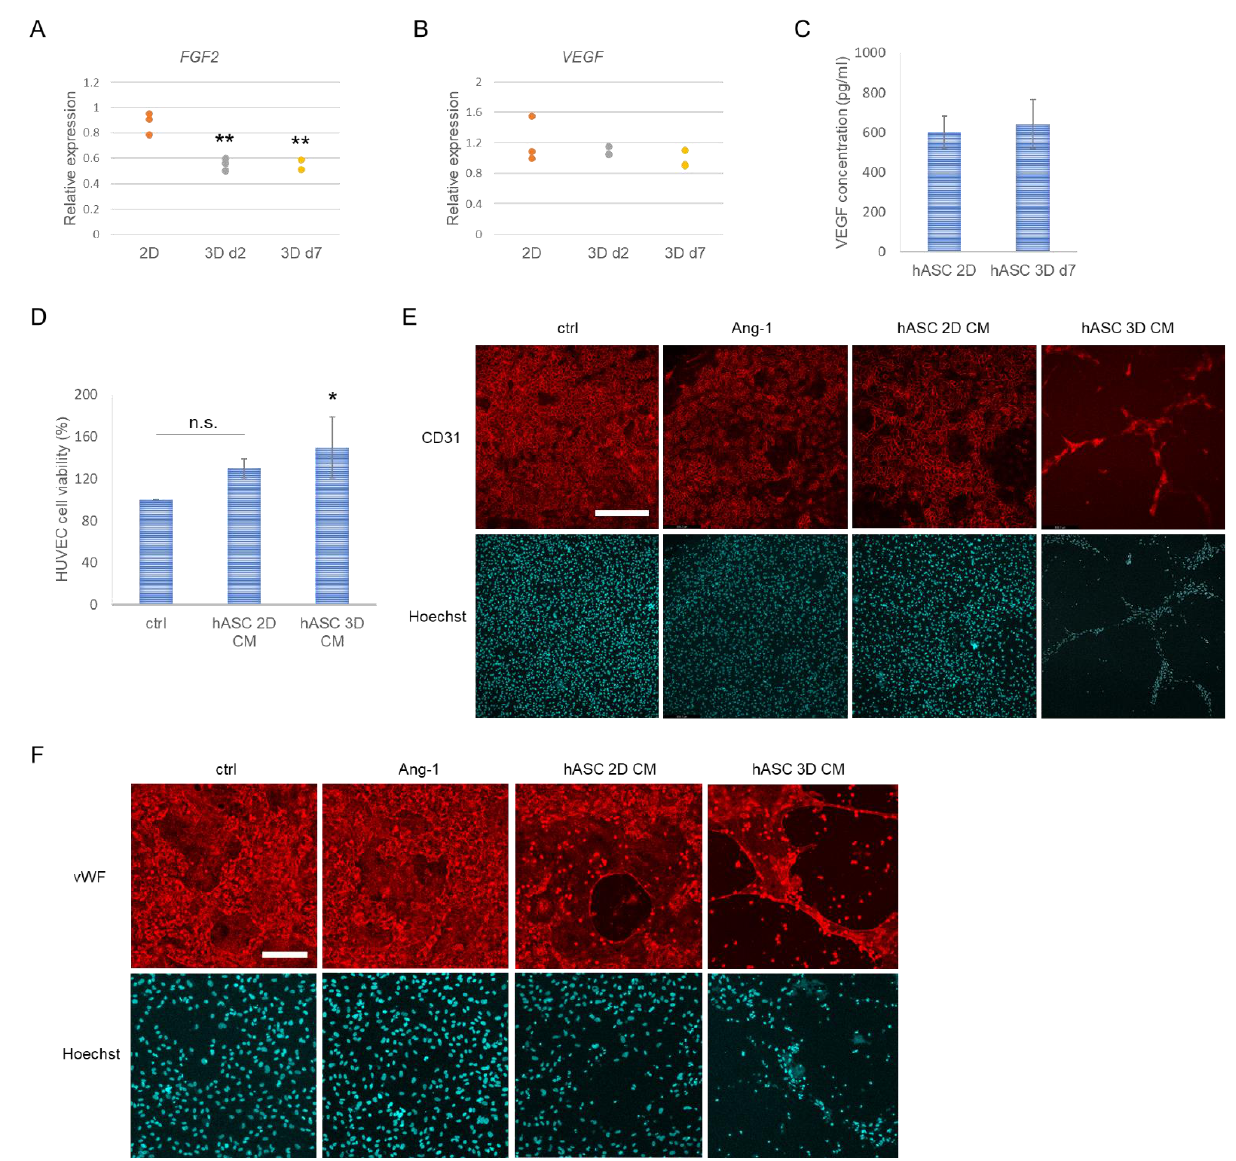
Figure 7. Angiogenic properties of hASCs in NFC hydrogel. ( A ) Relative expression of fibroblast growth factor 2 ( FGF2) quantitated by qRT-PCR ( n = 3, except for 3D d7 sample n = 2; 3 technical replicates). ( B ) Relative expression of vascular endothelial growth factor ( VEGF) quantitated by qRT-PCR ( n = 3; 3 technical replicates). ( C ) Secretion of VEGF quantitated by enzyme-linked immunosorbent assay ( n = 3; 2 technical replicates). ( D ) Effect of hASC-conditioned medium (CM; retrieved from 2D cultures or 3D cultures in NFC hydrogel) on HUVEC cell viability ( n = 3; 2 technical replicates). ( E ) Tube formation in HUVEC 3D cultures shown by CD31 staining of control, Ang-1, hASC 2D CM-, and hASC 3D CM-treated cells grown in 0.5% NFC hydrogel for 7 days. Scale bar, 400 µm. ( F ) HUVEC 3D cells stained with von Willebrand factor (vWF) antibody. Scale bar, 200 µm. Nuclei were stained with Hoechst. * p < 0.05 vs. ctrl, ** p < 0.01 vs. 2D. N.s., not signif-